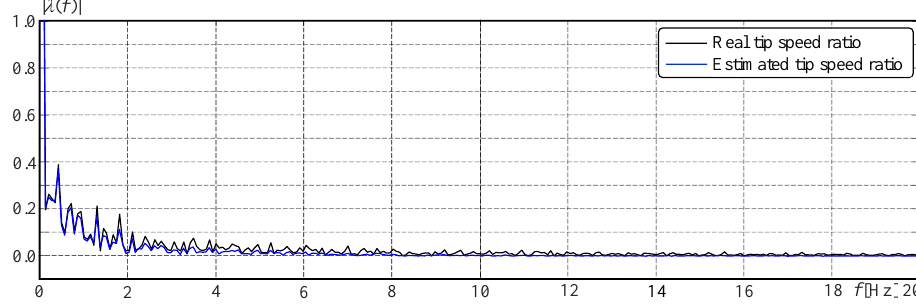
Figure 10. Single-side amplitude spectrum of the tip-speed ratio.